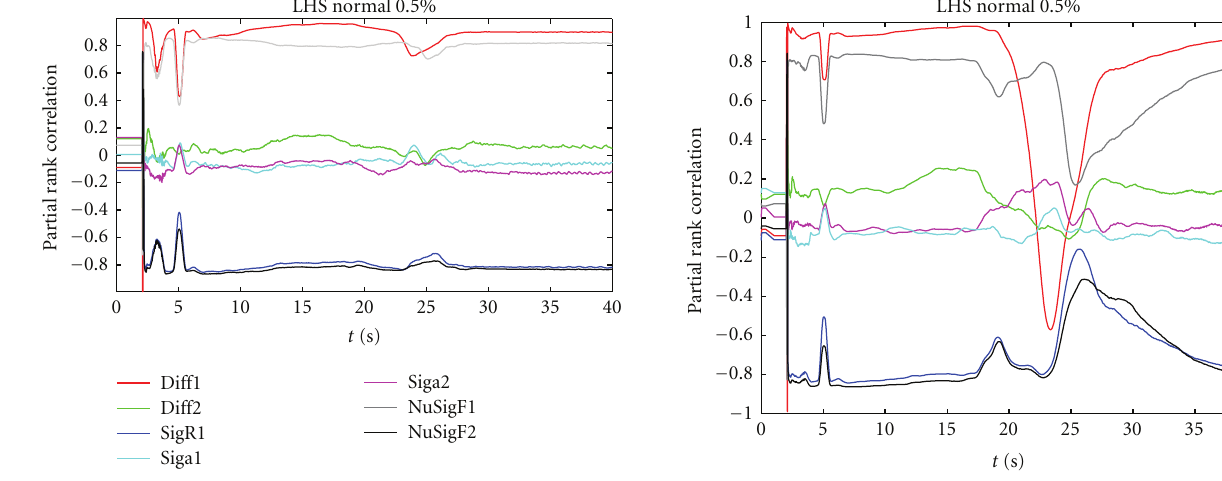
Figure 10: Partial Rank Correlation Coe ffi cient LHS Normal 0.5%, output variable:Power.